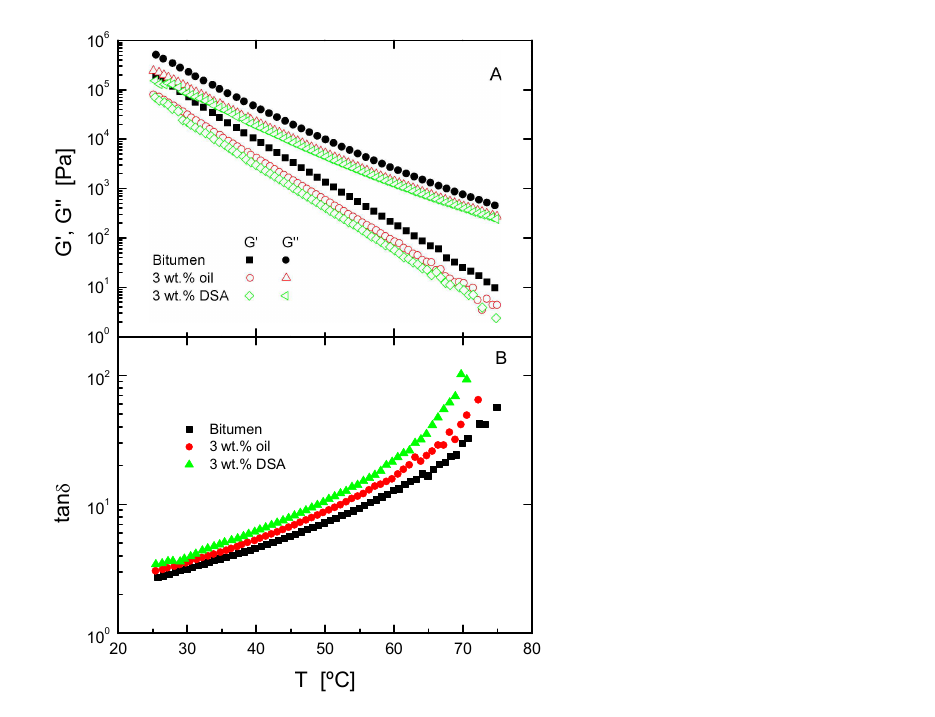
Figure 1. Temperature sweep tests in oscillatory shear, at 10 rad/s, for neat bitumen and unaged modified bitumen at intermediate and high temperatures. ( A ) Evolution of the storage, G′, and loss moduli, G″ and ( B ) loss tangent, tan δ, as a function of temperature. Table 3. Selected AASHTO parameters for neat and modified bitumens.